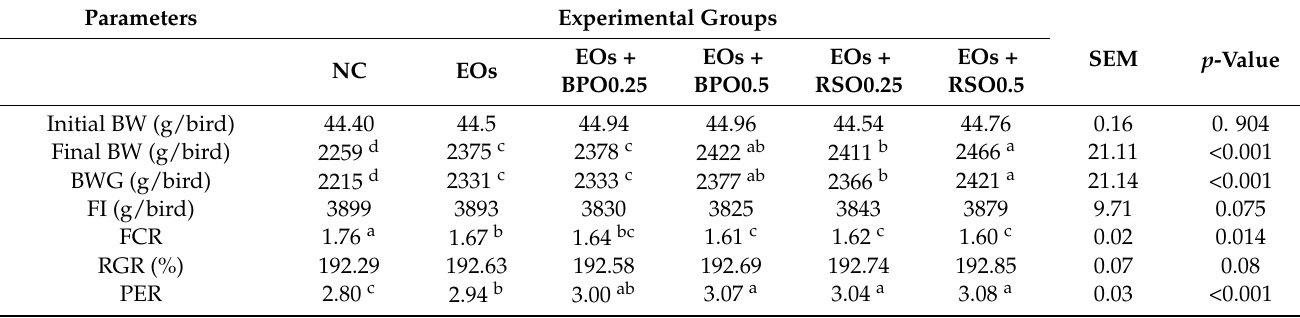
Table 3. Effect of EOs with black pepper oil or radish seeds oil on growth performance of broiler chickens. Parameters Experimental Groups